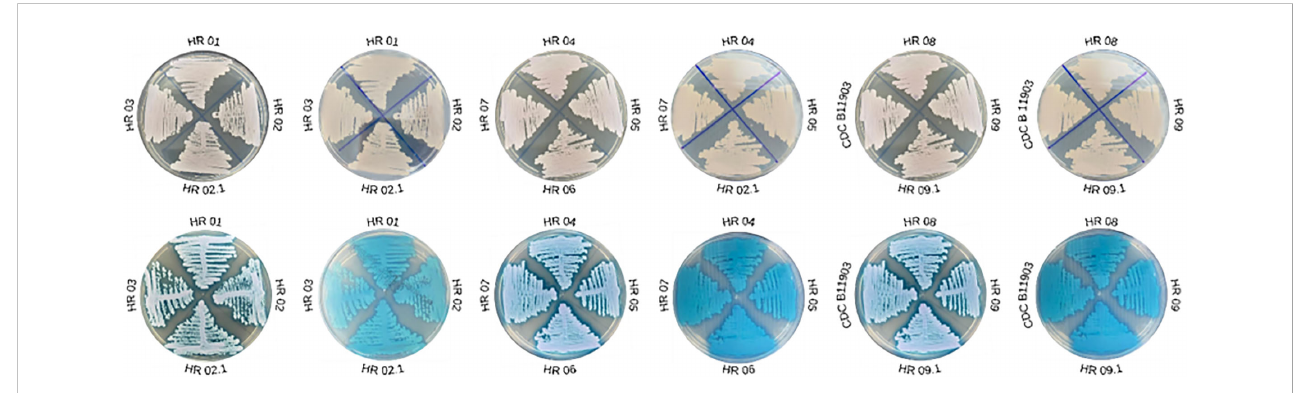
FIGURE 1 Growth of Candida auris clinical isolates on conventional CHROMagar ® Candida (Difco, Becton-Dickinson and Company, USA) versus CHROMagar Candida Plus ™ (CHROMagar,